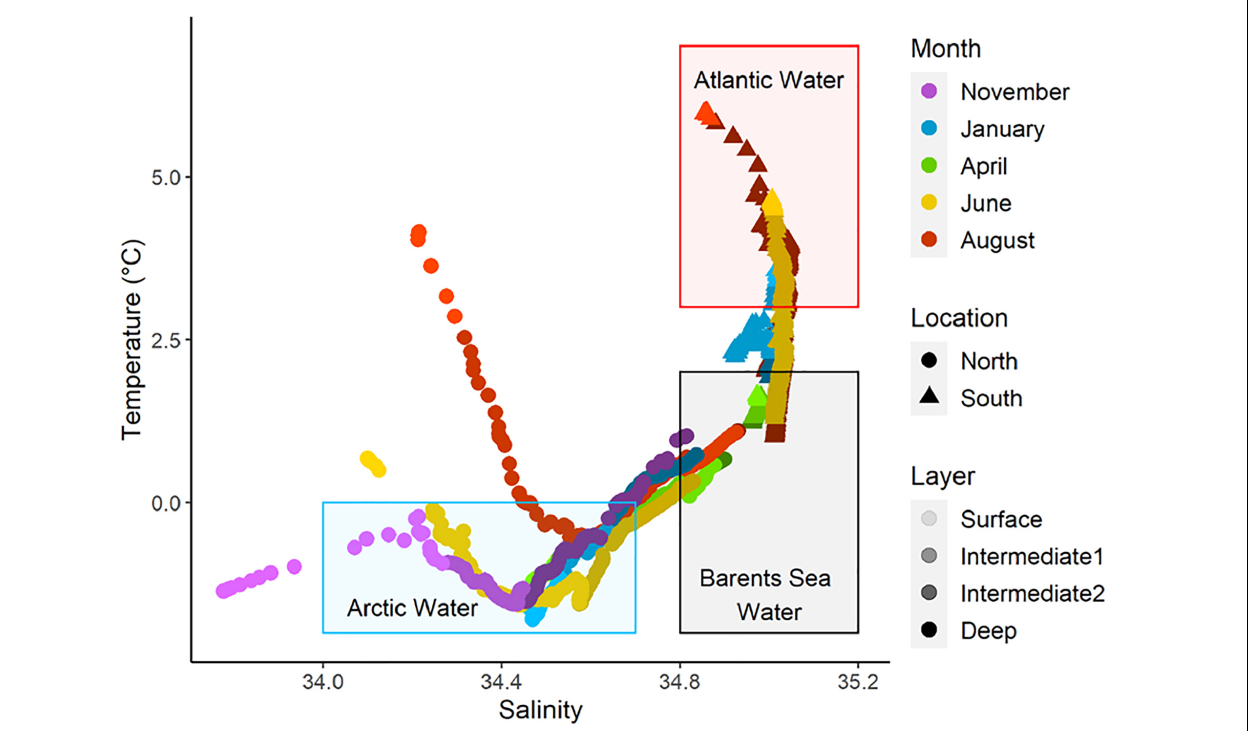
FIGURE 2 | Temperature and salinity diagram of water masses in the Barents Sea where meroplankton was collected. The colored rectangles represent the major water masses encountered during this study: Atlantic Water (red), Arctic Water (blue) and Barents Sea Water (gray). For the data points, each color palette represents a sampling month. The tone variations within each color palette represent the different water layers with darker tones representing deep layers and lighter tones surface layers.